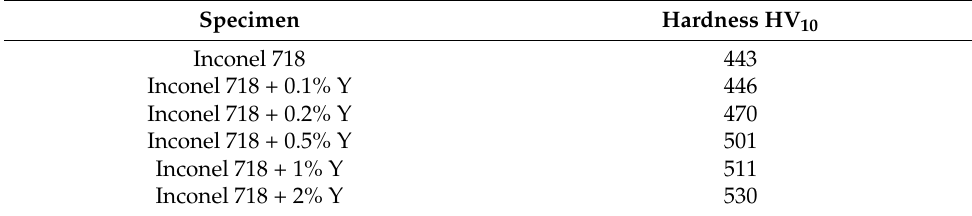
Table 2. Hardness HV 10 of the